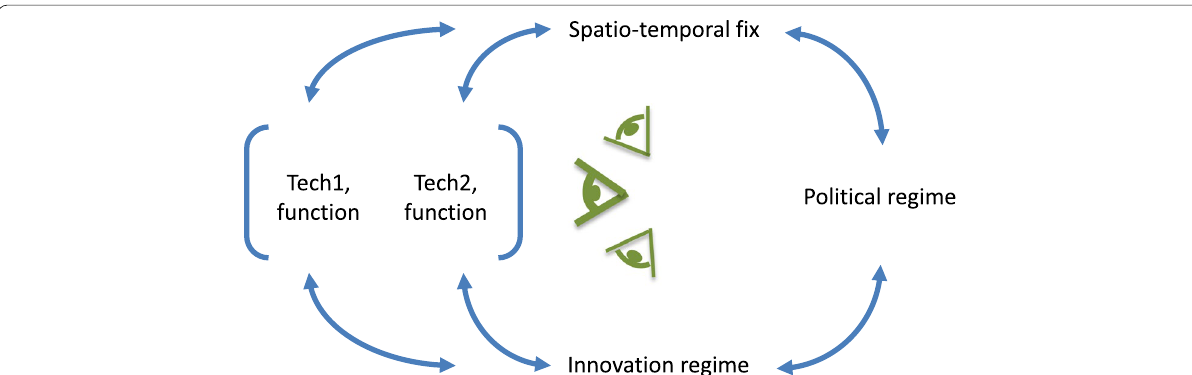
Fig. 1 The cultural political economy of mitigation deterrence framework (adapted from [31]). Note: The eye symbols in the middle of the figure indicate the multiple possible viewpoints of the actors implicated in the system, including us as analysts. The dominating, system-conservative viewpoint, indicated in bold, strongly shapes the framing of technologies, such that they tend to fit with and support the regime. There is some scope also for alternative viewpoints to impact on the co-evolution of the system. Strategic reflexivity and material subversiveness is thus